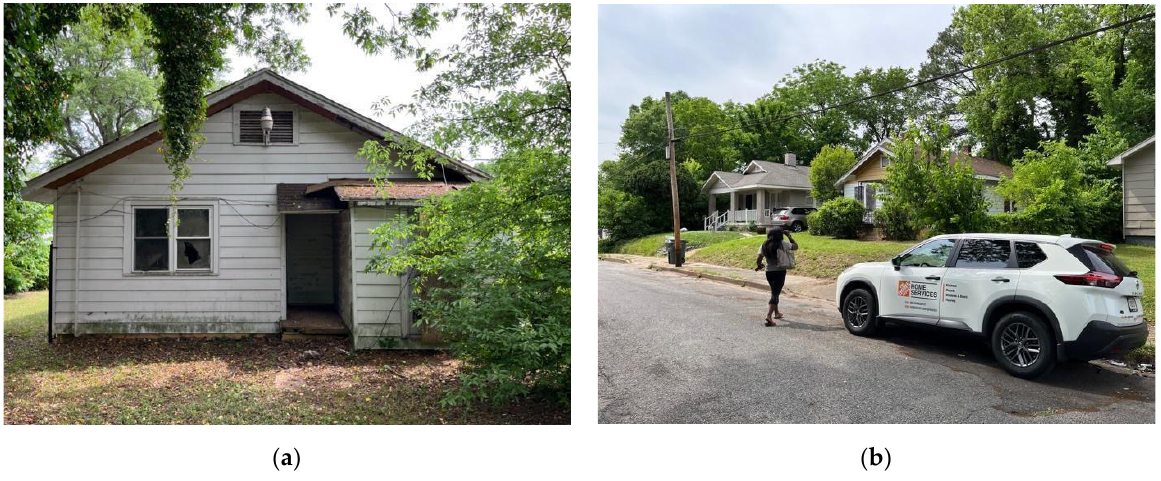
Figure 6. ( a ) The back side of a newly purchased house shows the extent of the renovations that MSH is undertaking. ( b ) The new house under renovation is in a neighborhood of single-family homes. MSH cultivates trust with neighbors through informal everyday interactions.